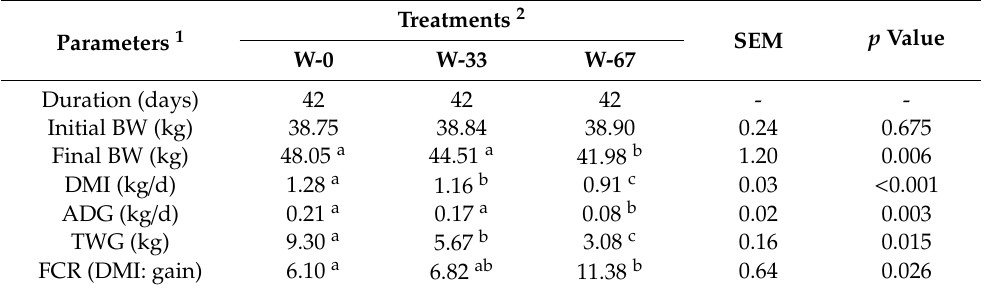
Table 2. Production performance of water-restricted male Najdi lambs fed a pelleted diet.